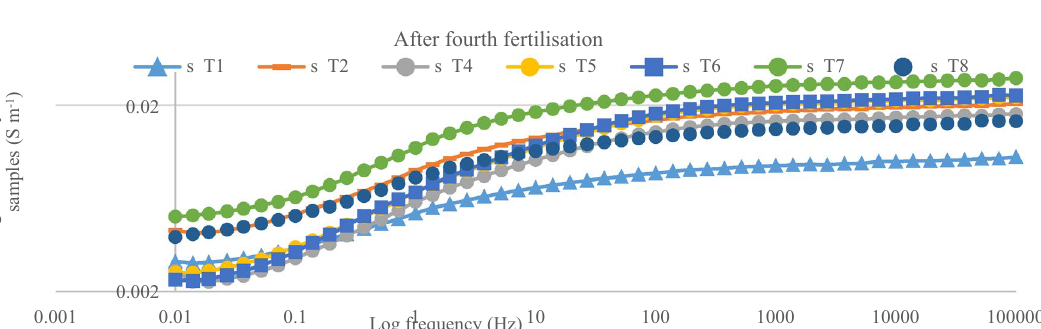
Figure 8. Conductivity of soil samples after third fertilization (55 days after transplanting) within 0.01 Hz and 100 kHz.